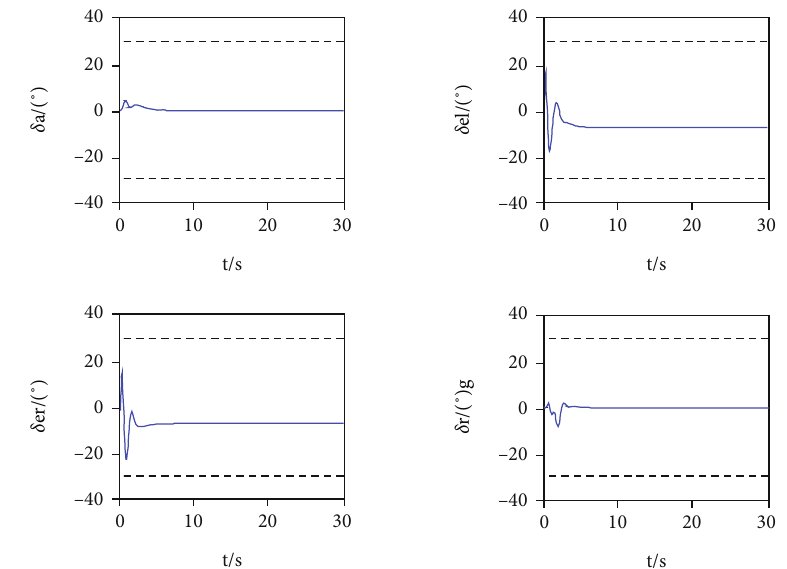
Figure 4: The de fl ection angle of surfaces. The forces and torques created by the four independent surfaces contribute to the aircraft ’ s three- axis maneuver.